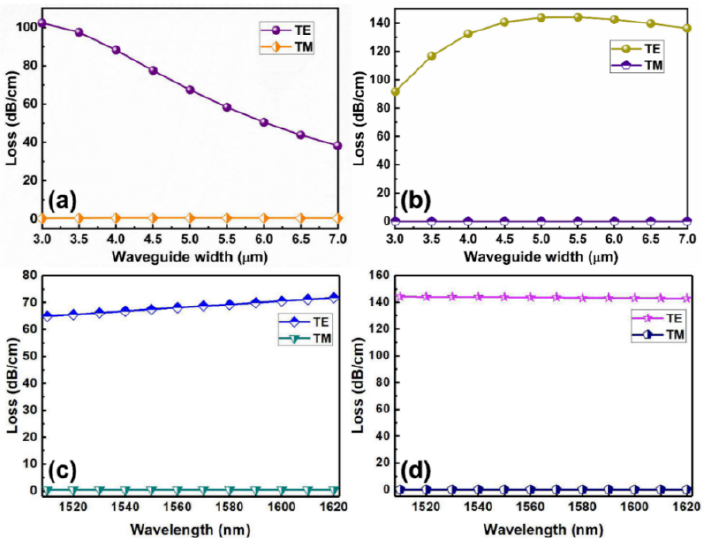
Figure 2. Variation of the change in the modal loss induced by the graphene film with the core dimension when the graphene film was placed ( a ) on the surface of core layer and ( b ) buried in the center of core layer. The fundamental mode loss characteristics of graphene films ( c ) on the surface of core layer and ( d ) buried in the center of core layer in the hybrid waveguides.